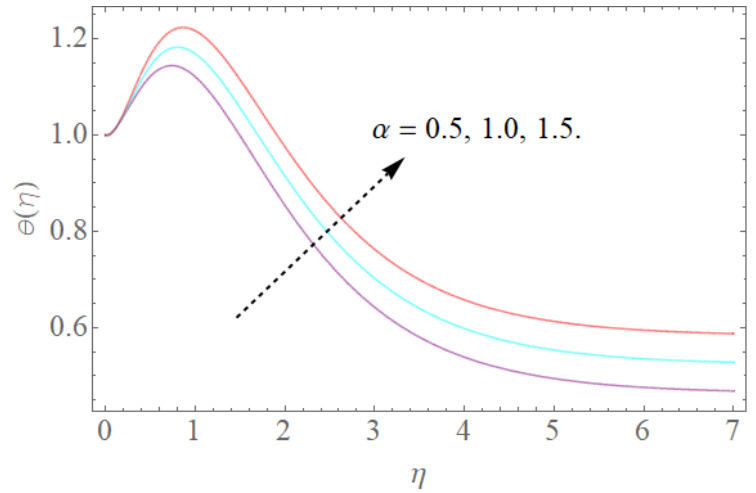
Figure 9. The effect of α on θ ( η ) when N t = 0.2,Pr = 12, N b = 0.5.